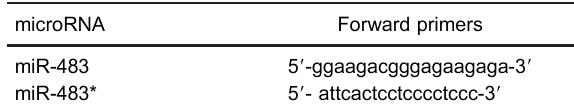
Table 2. Primers for detecting miRNA expression by qRT-PCR.